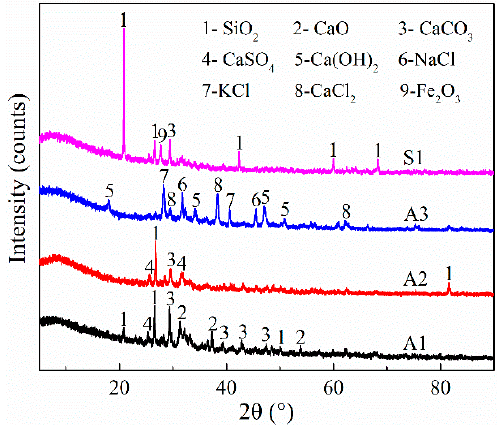
Figure 10. XRD of waste incineration in ash and slag.